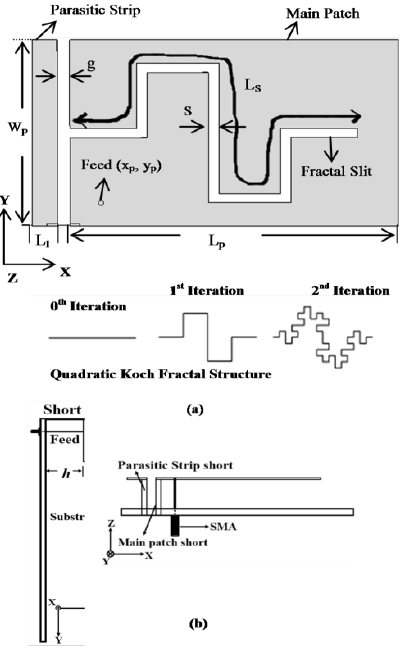
Figure 1: Geometry of the proposed antenna (a) top view and (b) side views.